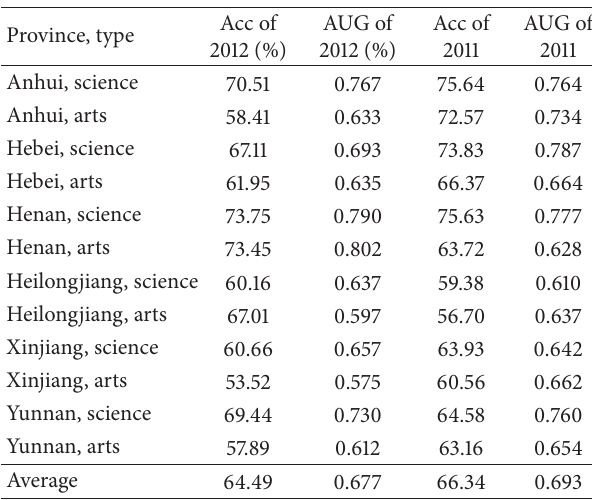
Table 4: Overall experimental results.